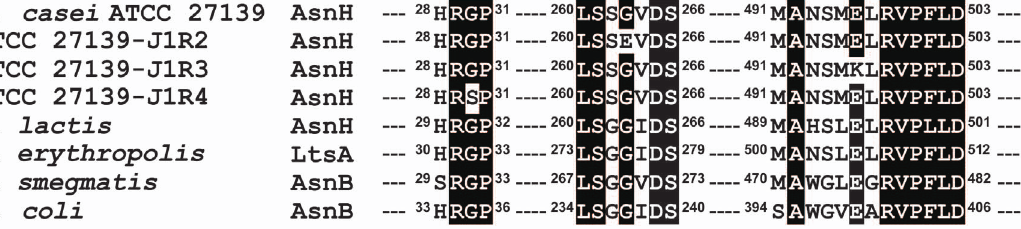
Figure 6. Partial sequence alignment of L.casei AsnH and orthologs. Partial sequences were selected from highly conserved regions of the following L. casei AsnH orthologs: L. lactis , R. erythropolis , M. smegmatis , and E. coli . A black background indicates identical residues in all bacteria.